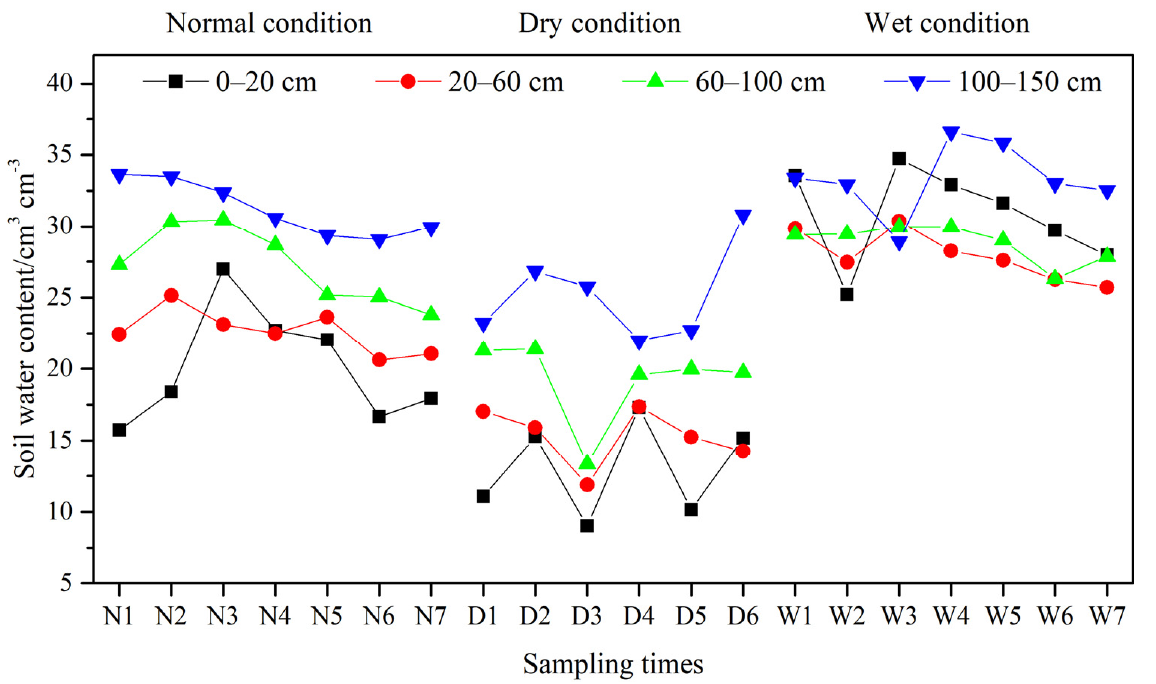
Figure 2. Variations of gravimetric soil water content (VSWC) in different soil layers under the normal, dry and wet conditions.